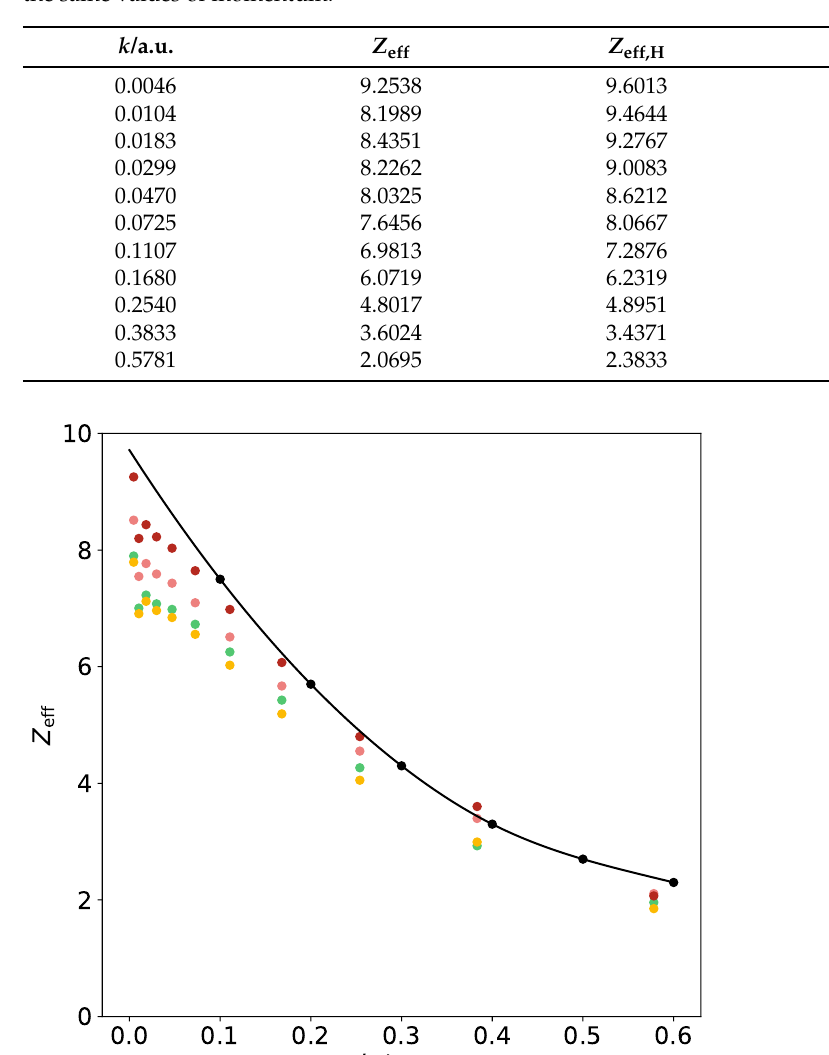
Figure 10. Z eff values obtained in the two-particle model using one (green), three (yellow), five (pink) and nine (red) terms in the wavefunction to describe correlations between the electron and positron. Black circles and line: results from [26] and their interpolation using cubic